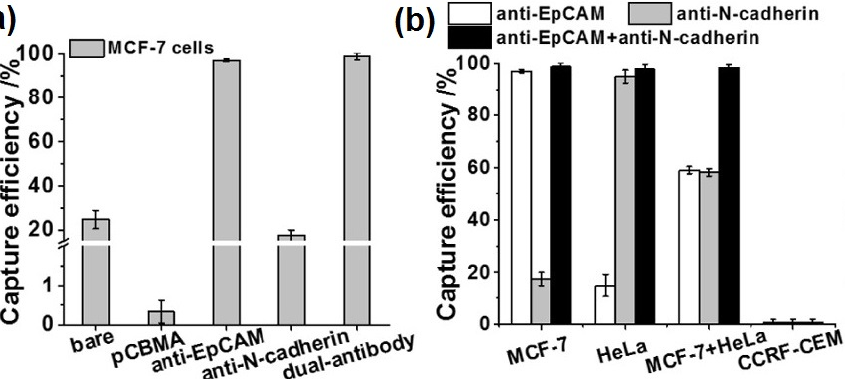
Figure 30. Comparison of the capture efficiency of F-MNPs under various modification conditions ( a ) for MCF-7 cells and ( b ) of anti-EpCAM-modified, anti-N-cadherin-modified, dual-antibody-modified F-MNPs for different cells. Adapted with permission from reference [133]. Copyright 2019 American Chemical Society.